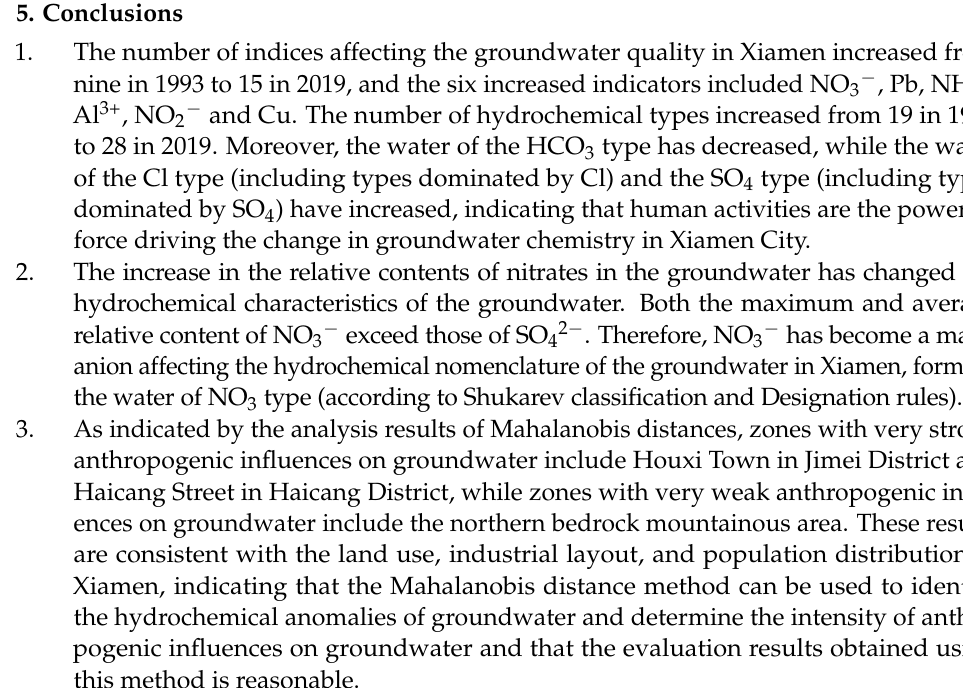
Figure 6. Map showing the zones of the intensity of anthropogenic influences on